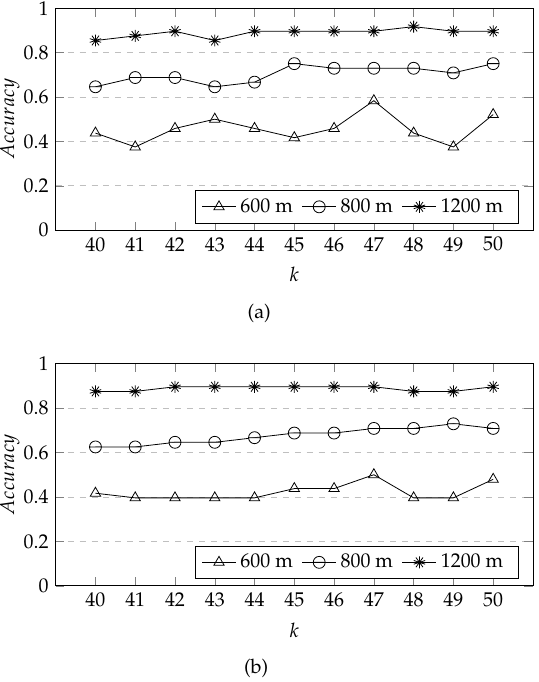
Figure 13. Varying fault-tolerant radius for prediction accuracy ( k ∈ { 40, . . . ,50 } ). ( a ) GMM algo- rithm; ( b ) K-means algorithm.